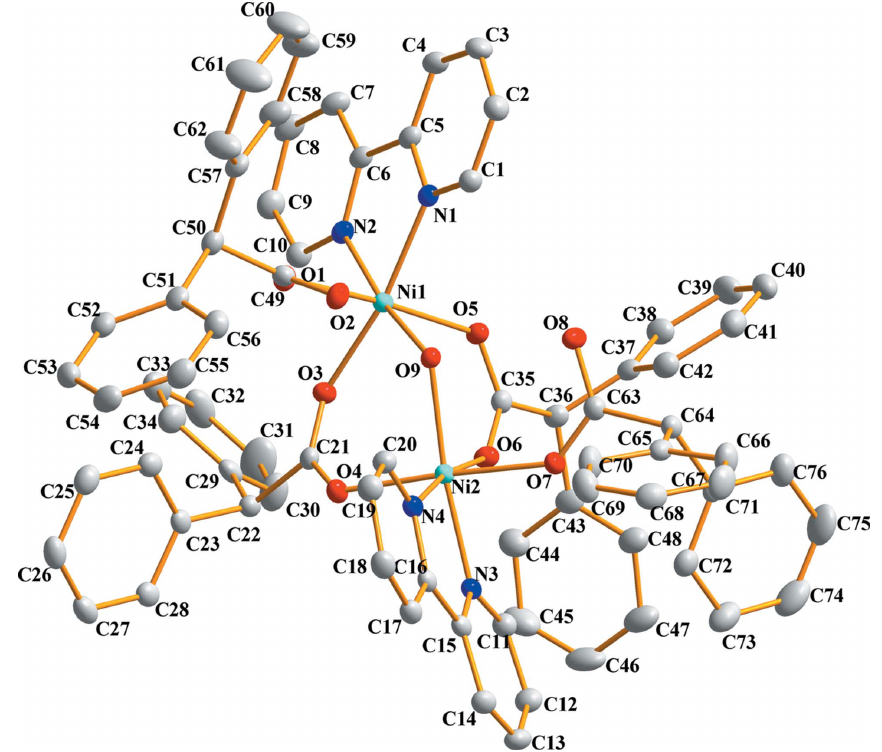
Figure 2 The molecular structure of 2 , showing the atom-labelling scheme. Displacement ellipsoids are drawn at the 50% probability level. H atoms and solvent molecules have been omitted for